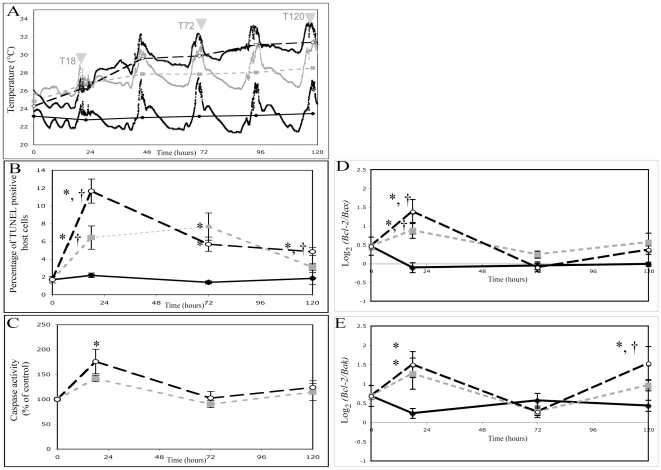
Effect of temperature on apoptotic mediators in Acropora millepora.(A) Temperature treatments for the duration of the experimental period (grey arrowheads indicate sampling points; dashed lines indicate daily average temperature; solid line indicate temperature recorded every 2 min). (B) percentage of TUNEL-positive host cells, (C) caspase 3-like activity expressed as percentage of control, (D) Log2 of Bcl-2 vs. Bax genes ratio and (E) Log2 of Bcl-2 vs. Bak genes ratio in A. millepora incubated in control (filled diamond), slow (grey square), and medium treatment (open circle). Error bars represent ± SEM, N = 3 coral branches for caspase 3-like activity and N = 6 coral branches for the other variables. *Significant difference (post-hoc LSD analysis, P<0.05) between treatment and control for the same time point. †Significant difference (post-hoc LSD analysis, P<0.05) between treatments for the same time point.